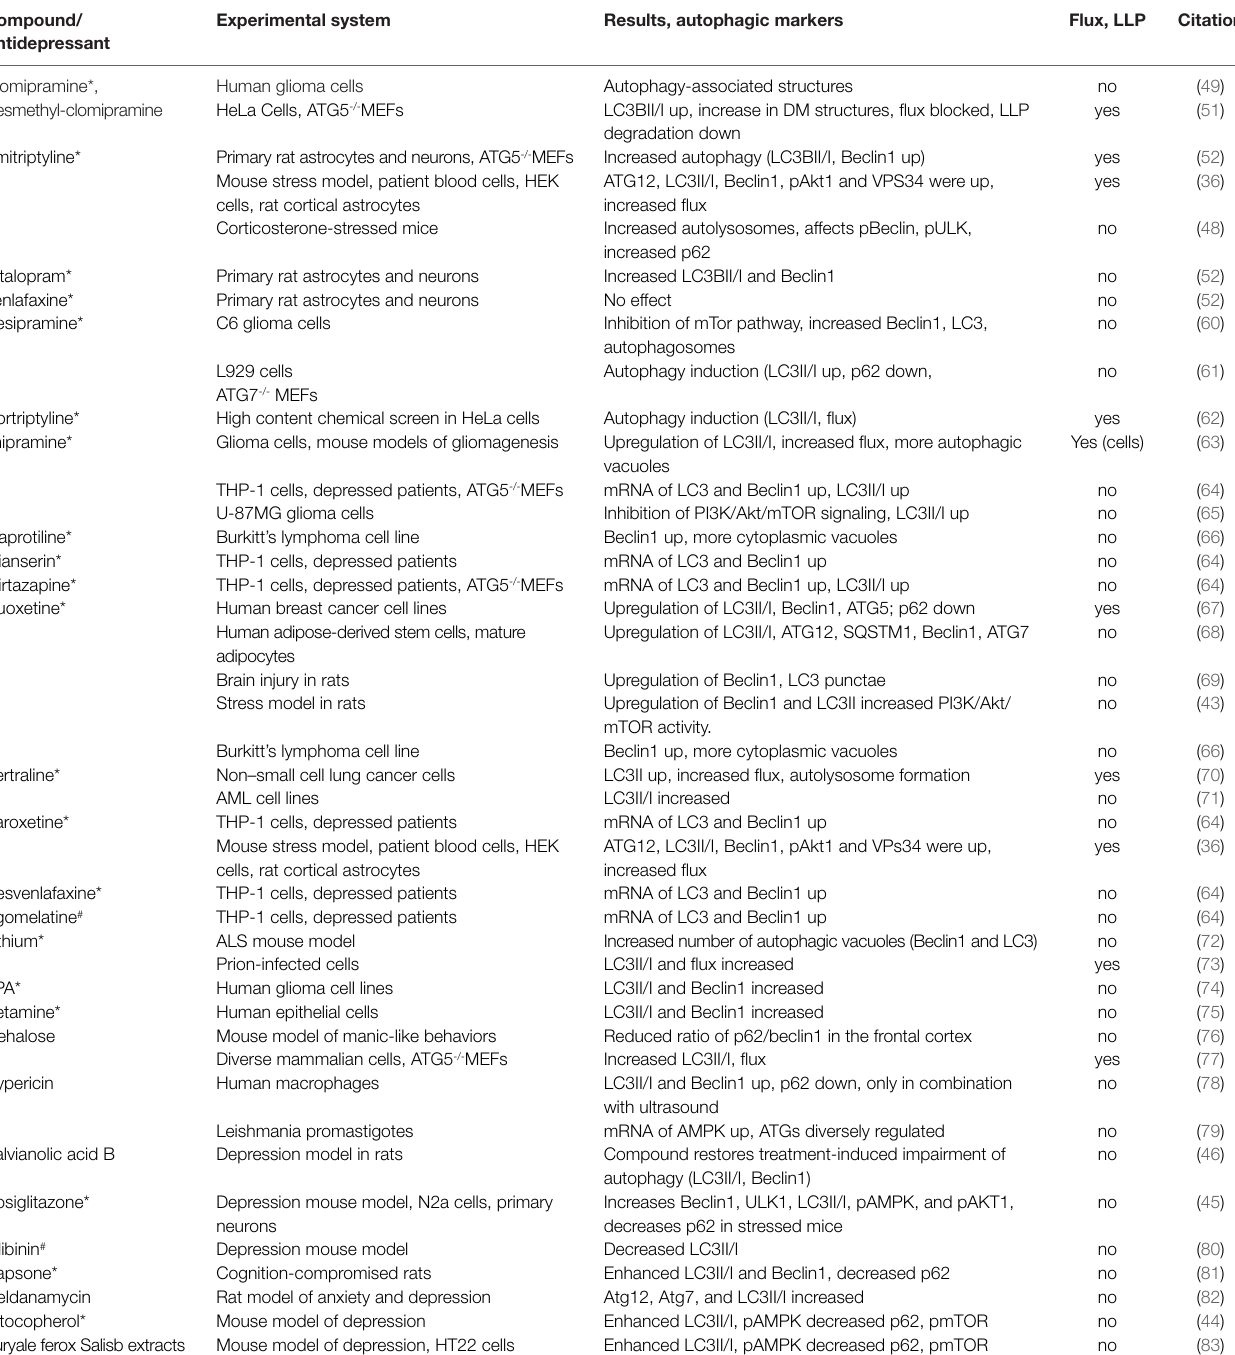
TABLE 1 | Overview of the various autophagy-impacting compounds that are used as antidepressants or reported to exert antidepressant-like effects in animal